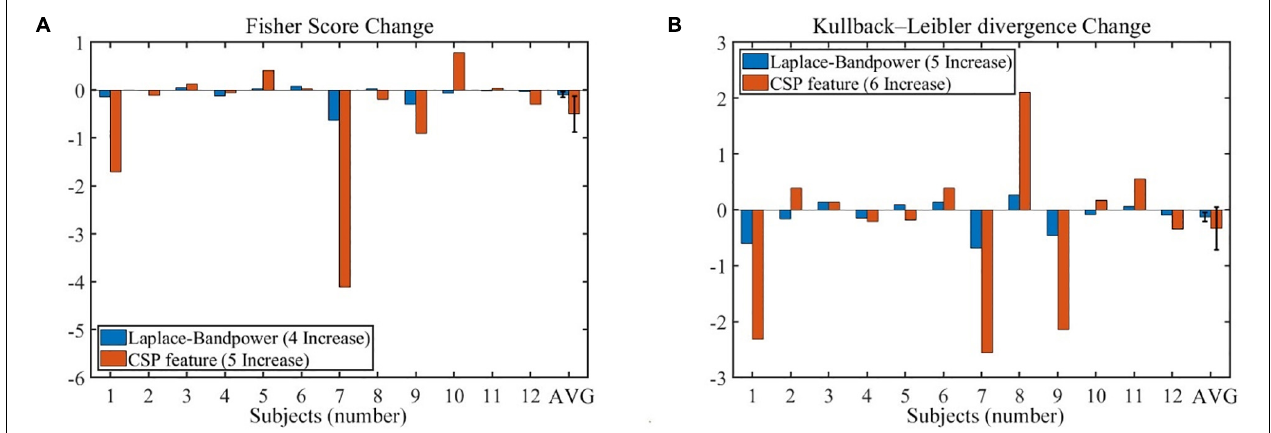
FIGURE 11 | The change of offline features separability during the no-rest session (201–400 vs. 1–200 trials). (A) The Fisher score changes of band power feature and CSP feature. (B) The Kullback–Leibler divergence changes of band power feature and CSP feature. Error bars indicate the SEM. CSP, common spatial pattern; SEM, standard error of